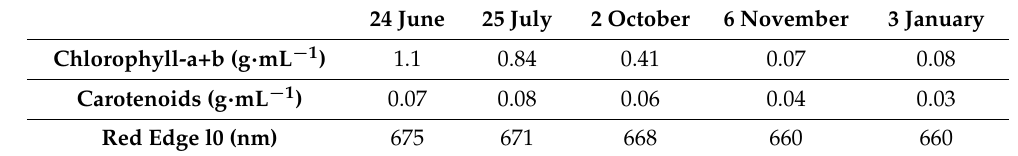
(needles) from healthy and PWN infected trees (60% healthy, 40% infected; m = 0.07, r 2 =